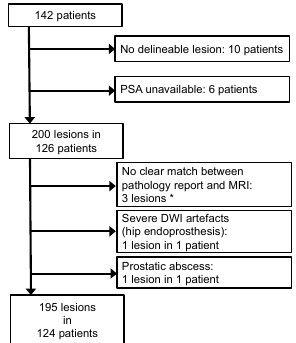
Figure 1. Patient flow chart. An initial database search retrieved 142 patients eligible for this retrospective study. However, 18 patients were excluded based on the exclusion criteria. In total, 124 patients with 195 lesions were included. (*) Three lesions could not be unambiguously matched between the pathology report and the MRI assessment. The affected patients, however, featured other lesions that were clearly matched.